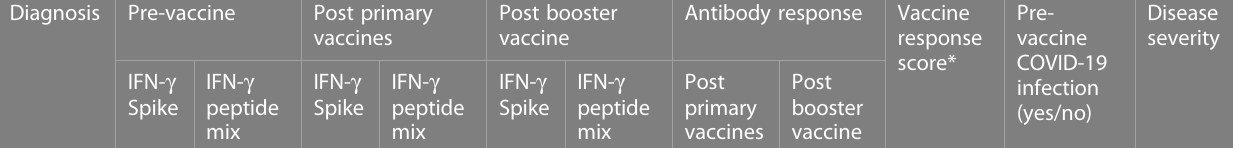
Diagnosis Pre-vaccine Post